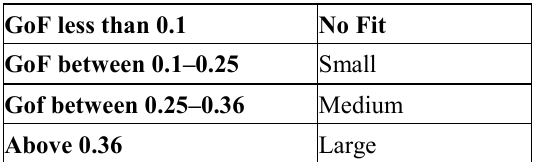
Table 8. Criteria of